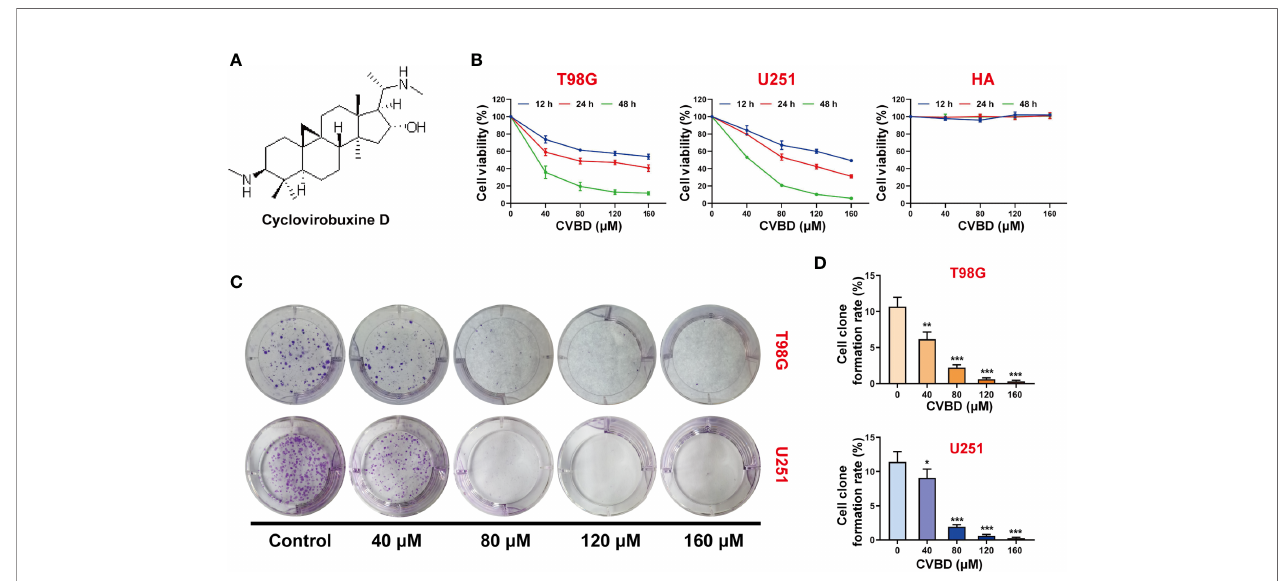
FIGURE 1 | CVBD inhibits cell proliferation and colony formation in glioblastoma (GBM) cells. (A) The chemical structure of cyclovirobuxine D (CVBD). (B) GBM cells (T98G and U251) and normal human astrocytes (HA) were treated with CVBD (40, 80, 120, 160 m M) for 12, 24, and 48 h. Cell viability was measured by CCK-8 assay, and 0 m M CVBD was used as a control group. (C, D) Colony formation was assessed by plate clone formation assay in T98G and U251 cells (mean ± SD of three independent experiments, *P < 0.05, **P < 0.01, ***P < 0.001 compared with the control